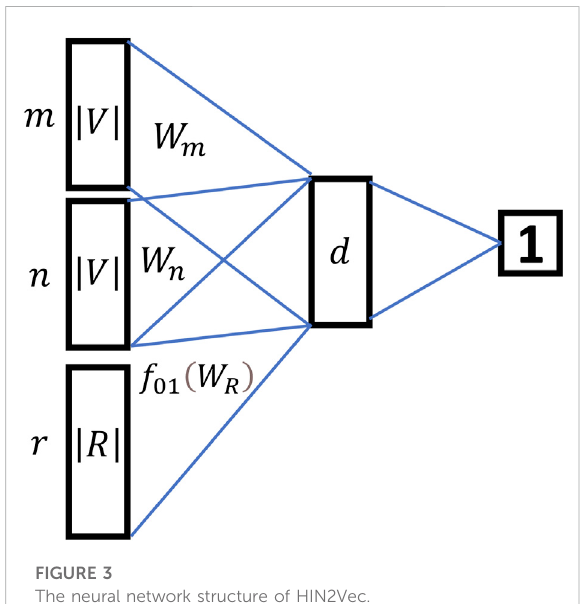
FIGURE 3 The neural network structure of